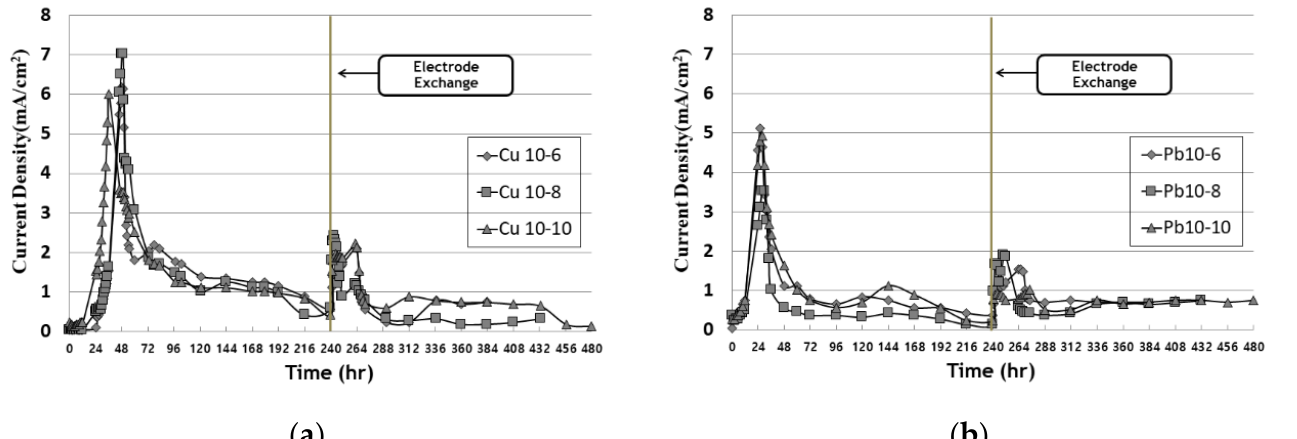
Figure 5. Current density during EK experiment: ( a ) copper; ( b ) lead.